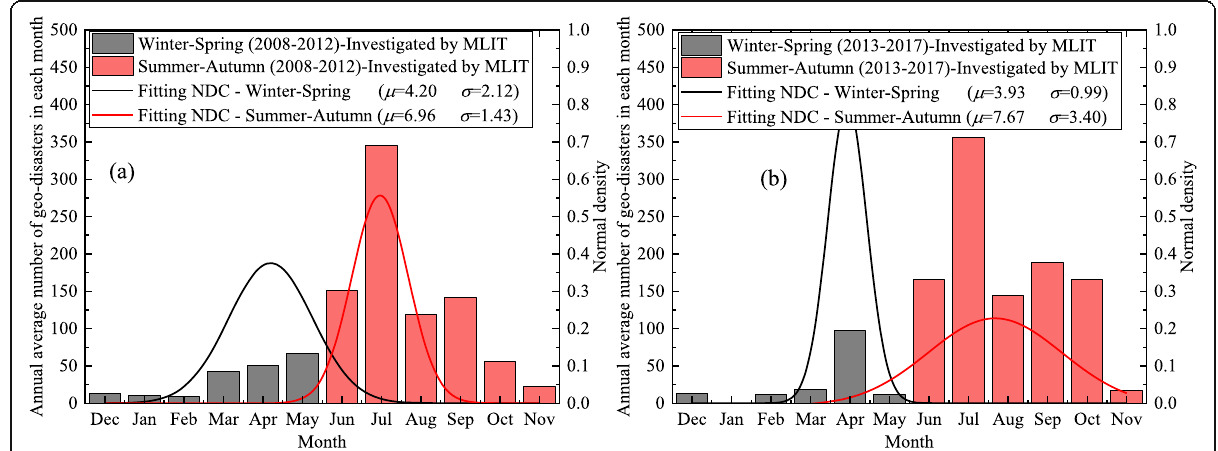
Fig. 10 Annual average number of slope failures in each month and the fitting normal density curve (NDC) of investigation results. a during